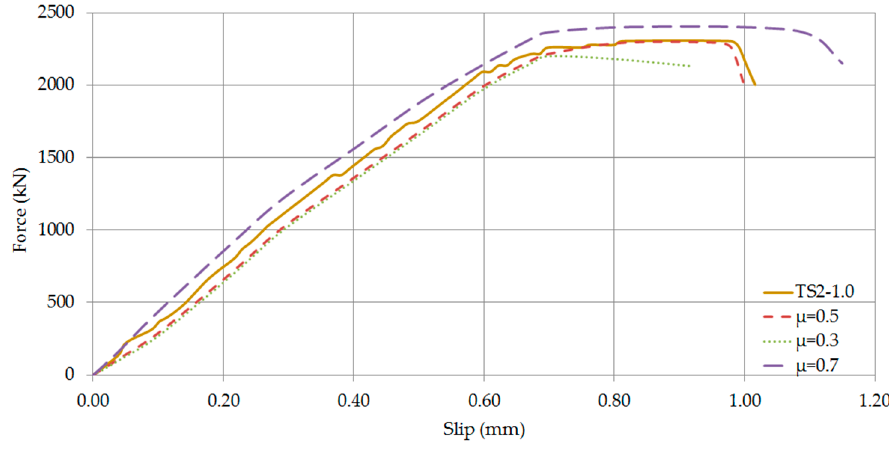
Computation 2017 , 5 , 12 Figure 26. Axial force—Slip Curves of TS2-0.6 (Comparison of friction coefficients).